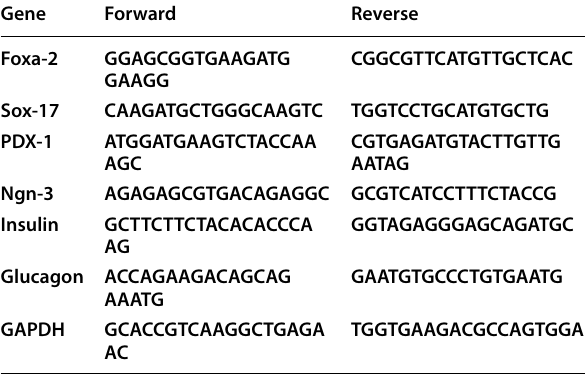
Table 1 List of human gene‑specific primers in RT‑PCR Gene Forward